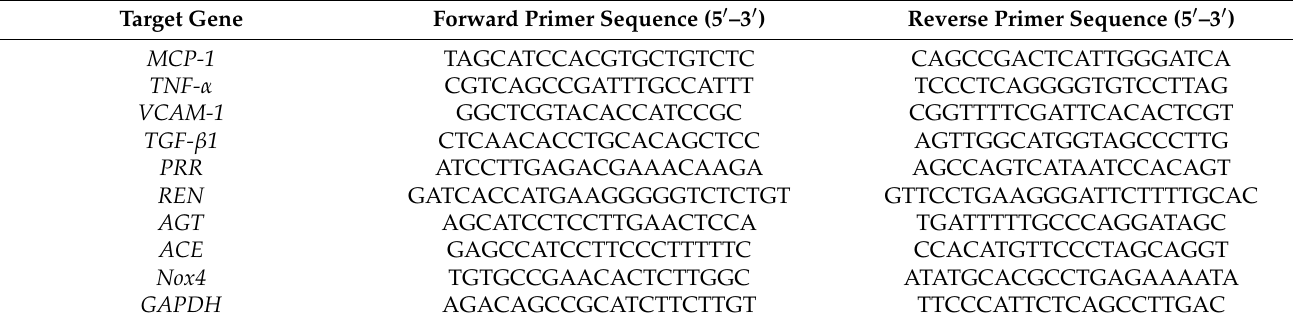
Table 1. Primers used for RT-qPCR analysis.